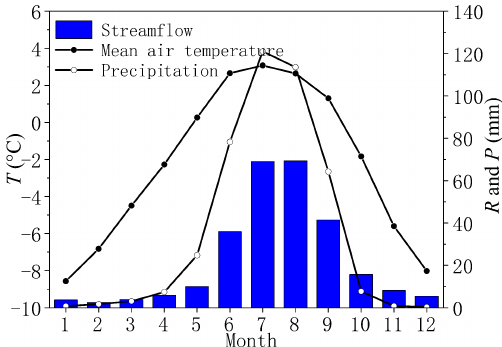
Figure 2. Seasonal variation in streamflow ( R ), mean air tempera- ture ( T ) and precipitation ( P ) in the Yangbajain